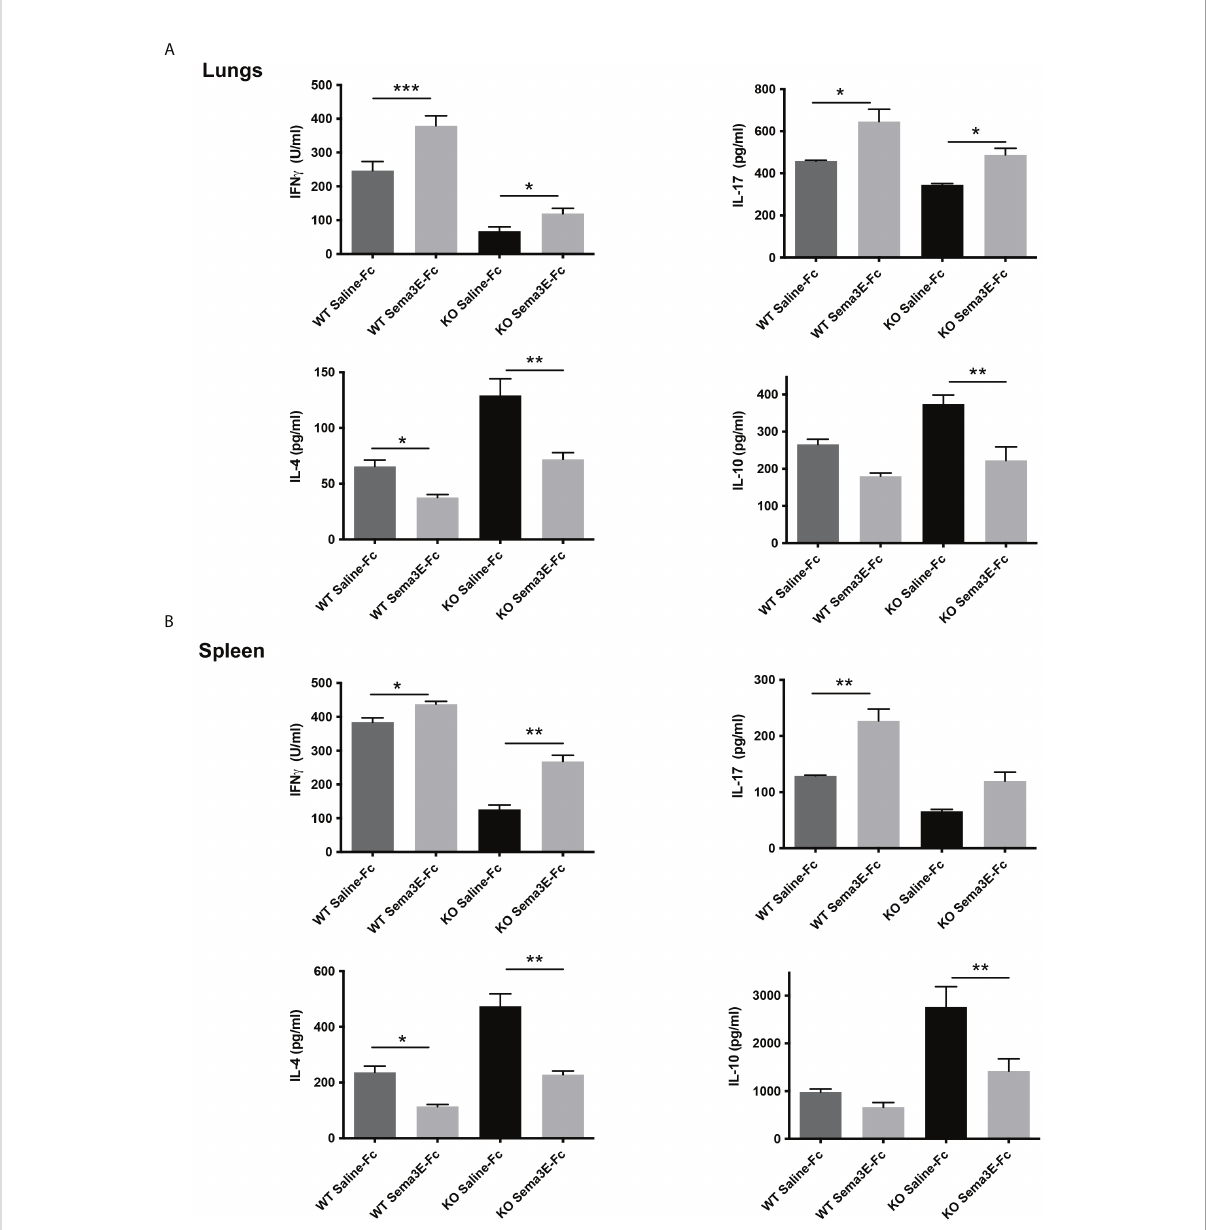
FIGURE 2 Semaphorin 3E treatment modulates antigen-driven cytokine responses after chlamydial infection. Exogenous recombinant Sema3E-Fc/Saline- Fc was administered to WT and Sema3E KO mice intranasally 2 hours before Cm infection (1x10 3 IFUs of Cm ) day 1 to day 6 after infection. Mice were sacri fi ced on day 7 post-infection. The spleen cells were cultured with UV-killed elementary bodies (UVEB). IFN- g , IL-17, IL-10, and IL-4 levels in 72-h culture supernatants were determined by ELISA. (A) IFN- g , IL-17, IL-10, and IL-4 cytokine production in lung cells at day 7 p.i. (B) IFN- g , IL-17, IL-10, and IL-4 cytokine production in the spleen at day 7 p.i. Data are shown as mean ± SD (n = 3) and represent one of three independent experiments with similar results. * p < 0.05, ** p < 0.01, *** p <